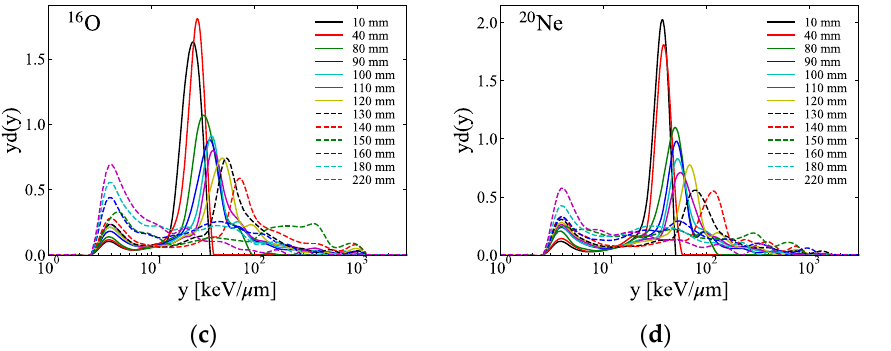
Figure 3. Typical microdosimetric lineal energy spectra measured utilizing the SOI MicroPlus- mushroom microdosimeter at several depth levels in the PMMA phantoms of the SOBP of the ( a ) 4 He-, ( b ) 12 C-, ( c ) 16 O-, and ( d ) 20 Ne-ion beams (the y on the horizontal axis in each figure is the value in the tissue calculated using the conversion factor of 0.58 between the tissue and silicon [22,29]).